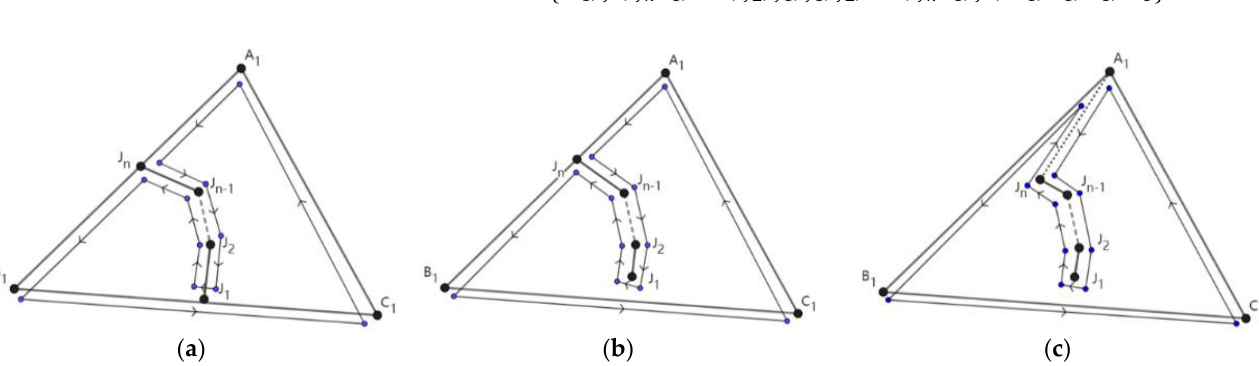
Figure 10b. The topological relationship of each triangle along the intersection line and extension line of the intersecting fault surface was updated according to the principle of geometrical topology consistency (Figure 11). ( a ) ( b ) Figure 10. Schematic diagram of triangulation cutting of intersecting triangles. Deleting all points on the closed polygon except the vertex in ( a ) to generate ( b ). ( a ) ( b )